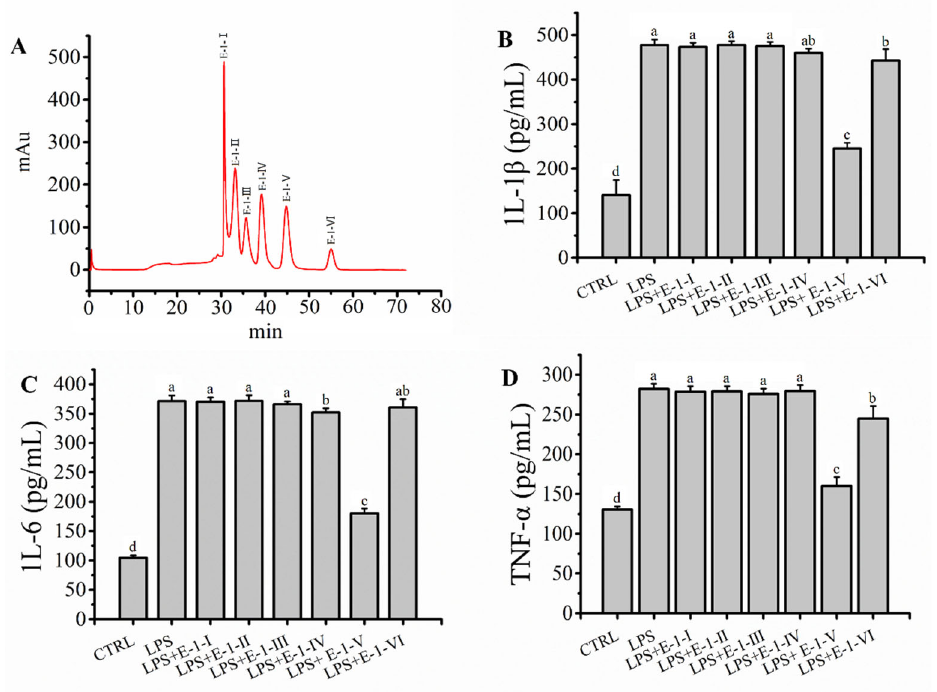
Figure 4. ( A ) BEH C18 reversed ‐ phase liquid chromatography of peptides from E ‐ 1; ( B – D ): Effects of E ‐ 1 ( Ⅰ – Ⅵ ) pre ‐ treatment (200 μ g/mL) on levels of IL ‐ 1 β , IL ‐ 6 and TNF ‐α on model of LPS ‐ medi ‐ ated RAW264.7 macrophages damage. Different letters (a, b, c and d) in the figure represent signif ‐ icant differences between groups ( p < 0.05).